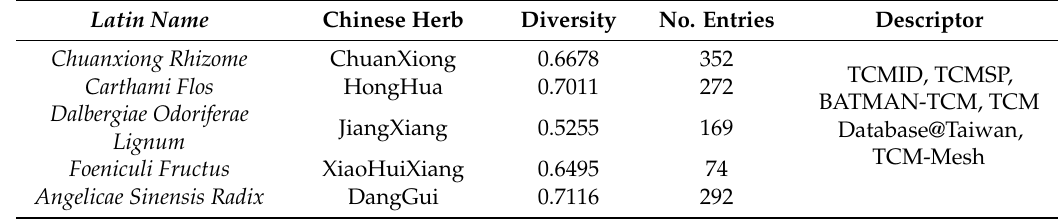
Table 2. Data sets on pungent compounds to evaluate structure